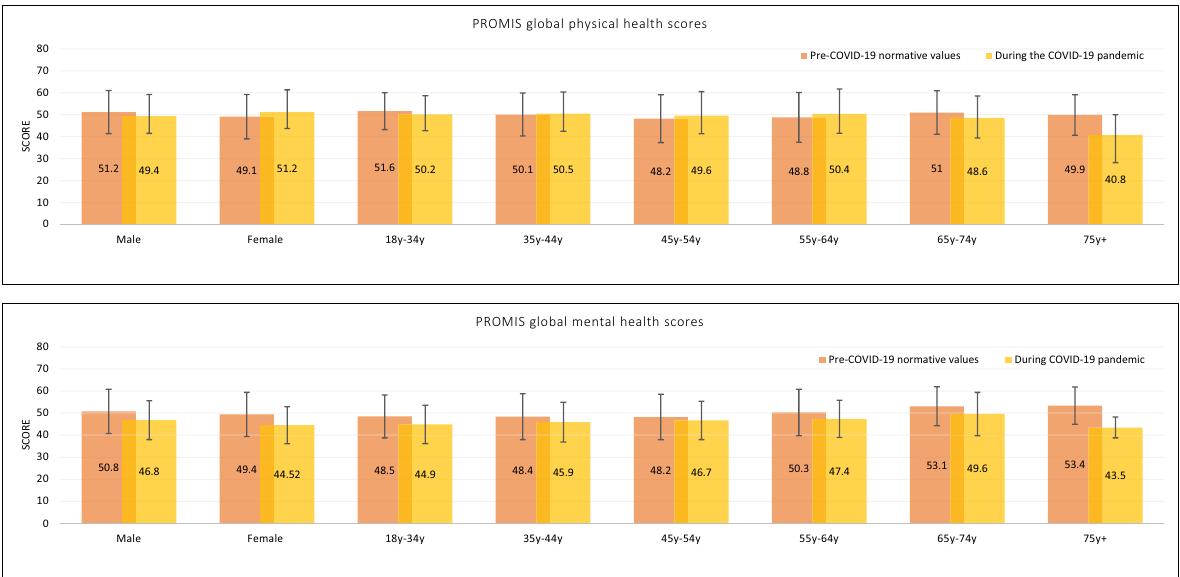
Fig. 1 PROMIS global physical and mental health T-scores—reference scores versus scores during the